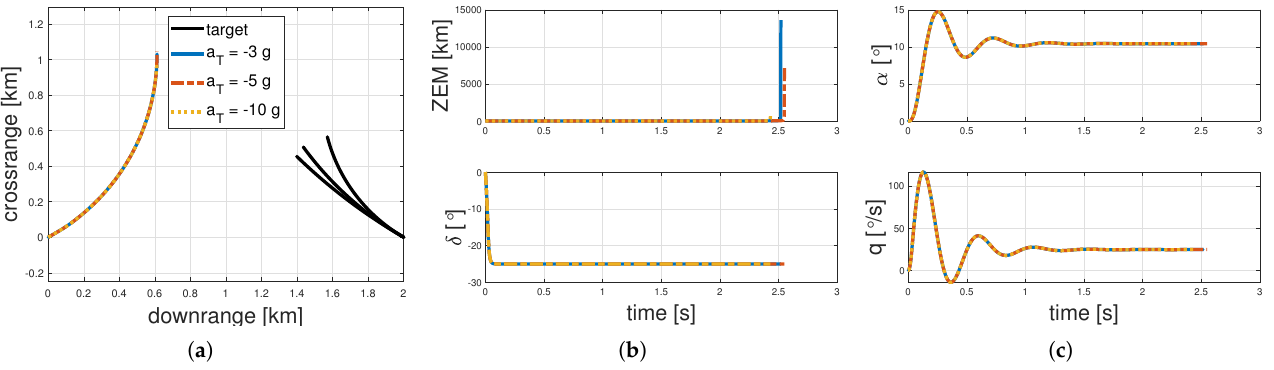
Figure 5. Simulation results of the separate method under the tail-controlled missile model. ( a ) Flight trajectories. ( b ) ZEM and fin deflections. ( c ) State variables.